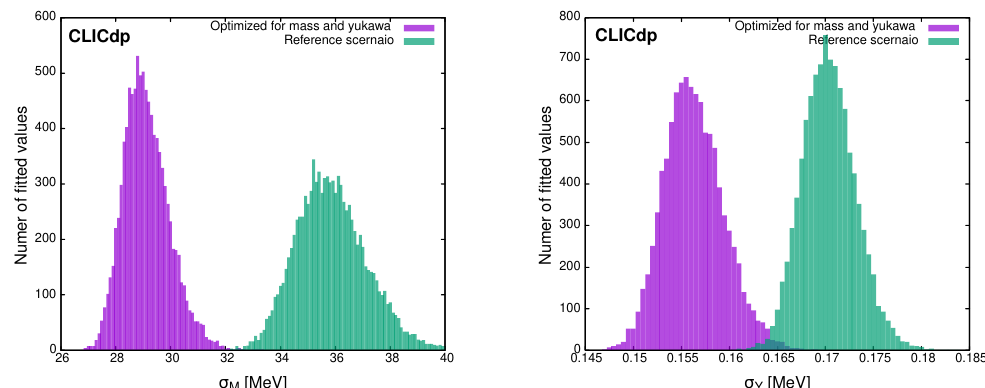
Figure 5: Mass (left) and Yukawa coupling (right) uncertainty distribution in scenario optimised for mass and Yukawa coupling measurement (see Fig. 3), collated with the the reference scenario’s distributions. Figure reproduced from [ 2 ]